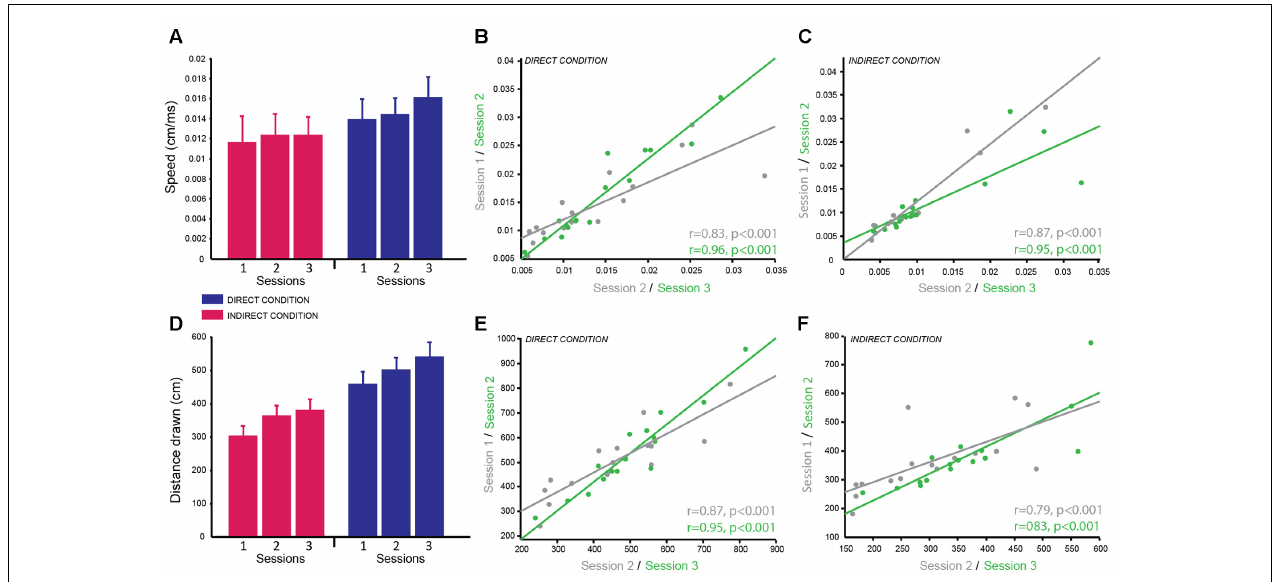
FIGURE 3 | Circle Tracing Task: good reliability of speed of tracing and distance measured across testing sessions. (A) Mean speed of tracing (cm/s) for the indirect condition (pink) compared to the direct condition (blue) across sessions. (B,C) Significant positive correlation of overall mean speed of tracing for each subject between sessions 1 and 2 (gray) and sessions 2 and 3 (green) for both the direct (B) and indirect (C) conditions demonstrating good test–retest reliability. (D) Mean distance traced (cm) for the indirect condition (pink) and the direct condition (blue) across sessions. (E,F) Significant positive correlation of mean distance traced for each subject between sessions 1 and 2 (gray) and sessions 2 and 3 (green) for both the direct (E) and indirect (F) conditions demonstrating good test–retest